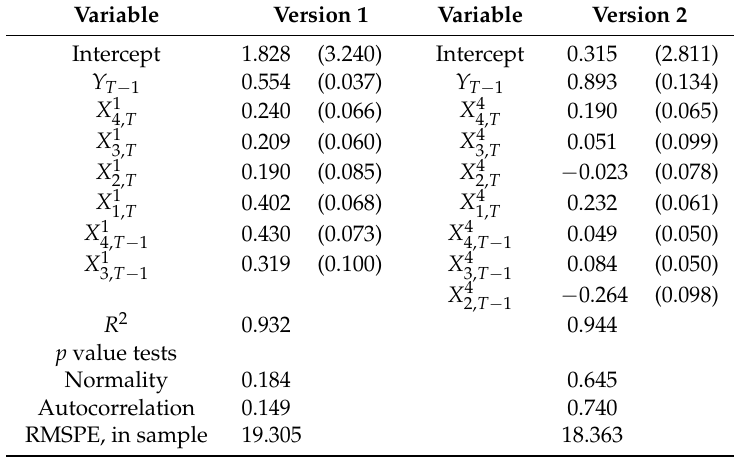
are the q , T are the fourth-order differenced q , T